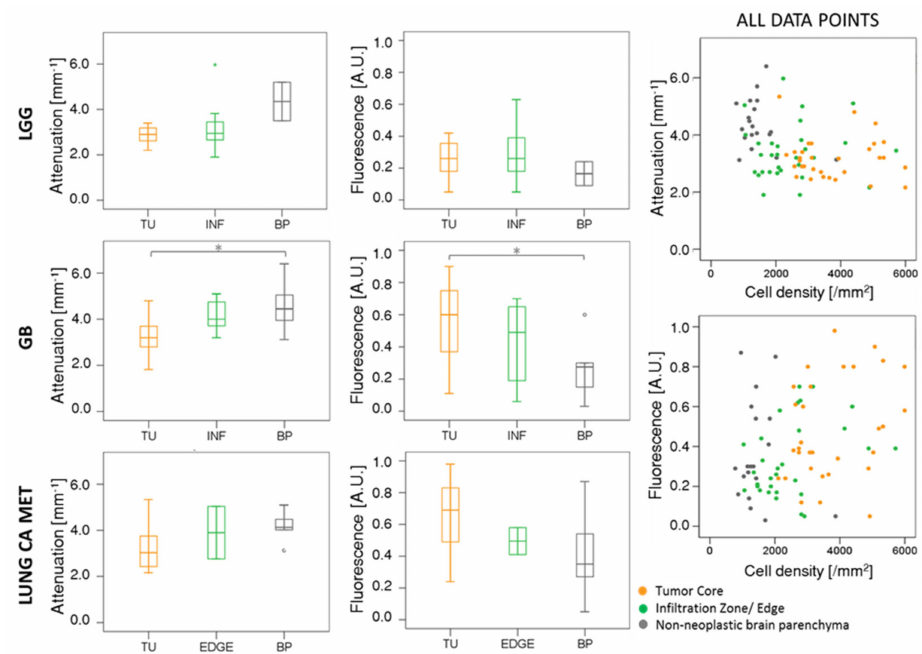
Figure 2. Comparison of median attenuation coe ffi cients (mm − 1 tissue depth) and normalized fluorescence intensities across di ff erent tumor entities. Scatter plots visualize every sample evaluated, where the axes represent attenuation coe ffi cient and quantitative 5-ALA fluorescence with respect to cell density (cells / mm 2 ). The color coding classifies the samples according to the tissue type assessed by